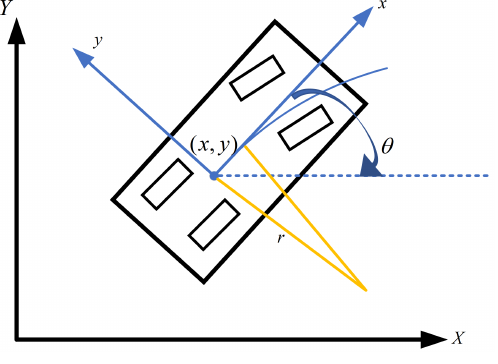
Figure 2. Robot kinematic